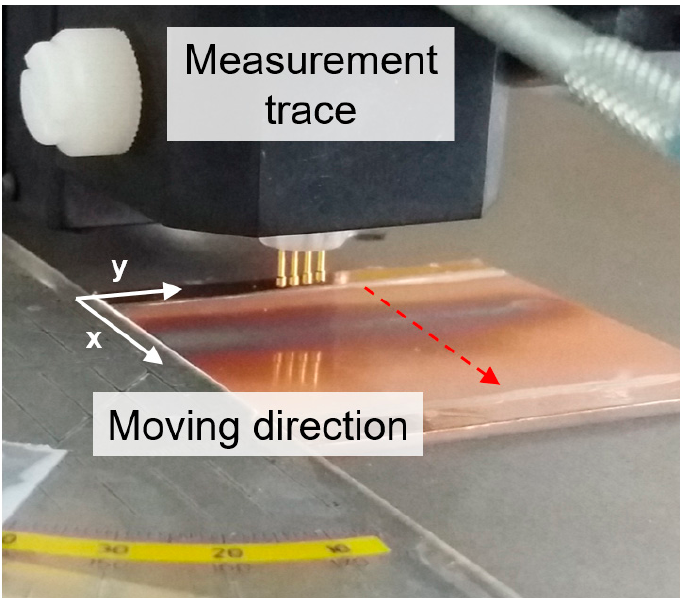
Figure A3. Photo for the four-probe measurement across a CuNW film after electrical breakdown.